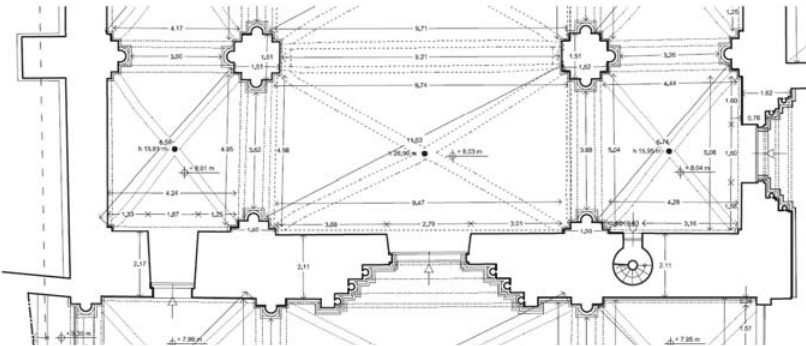
Figure 4a. Detail of the Plan of the church